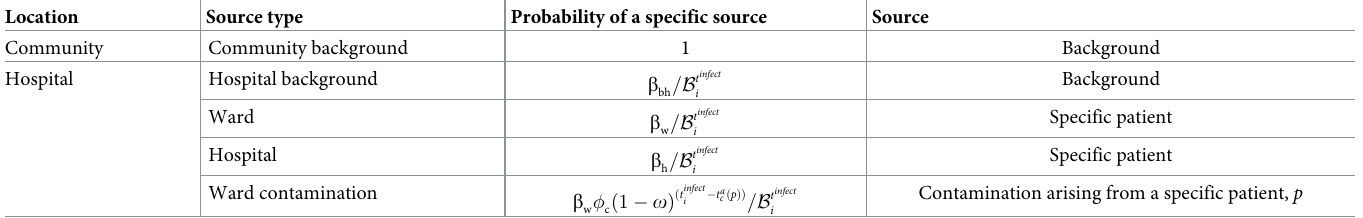
Table 2. Probability of infection by a given source patient or background